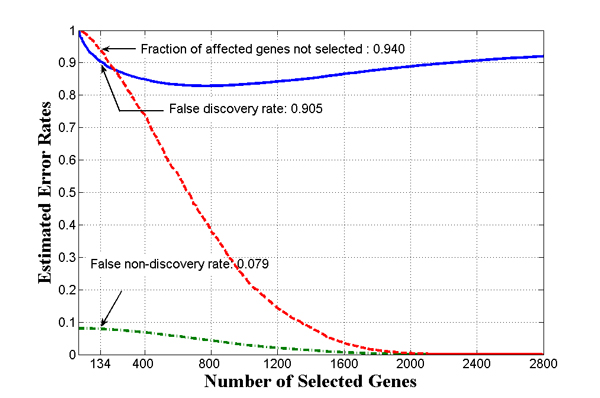
Expected classification errors for genes that are selected based upon their p-value from the t-test for a gender difference. When the genes are ordered by their p-values from the t-test of a gender difference, the horizontal axis indicates the set of genes selected as having a gender difference. The vertical axis plots associated estimates of the false discovery rate (solid blue line), false non-discovery rate (dash-dotted green line), and proportion of affected genes not selected (dashed red line). These estimates assume that 8% of the 2800 expressed genes, 224 genes, have a gender difference where the 8% was estimated by fitting a mixture of distributions model to the observed p-values.